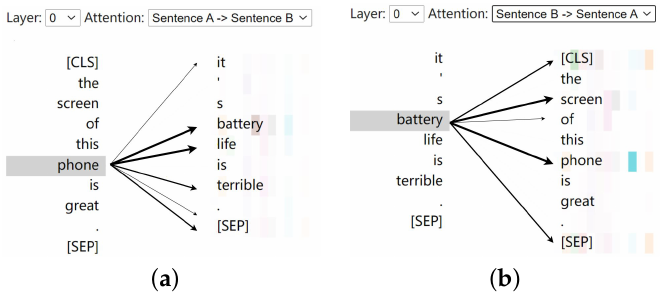
Figure 1. Visualization of BERT Attention. ( a ) Sentence A to B. ( b ) Sentence B to